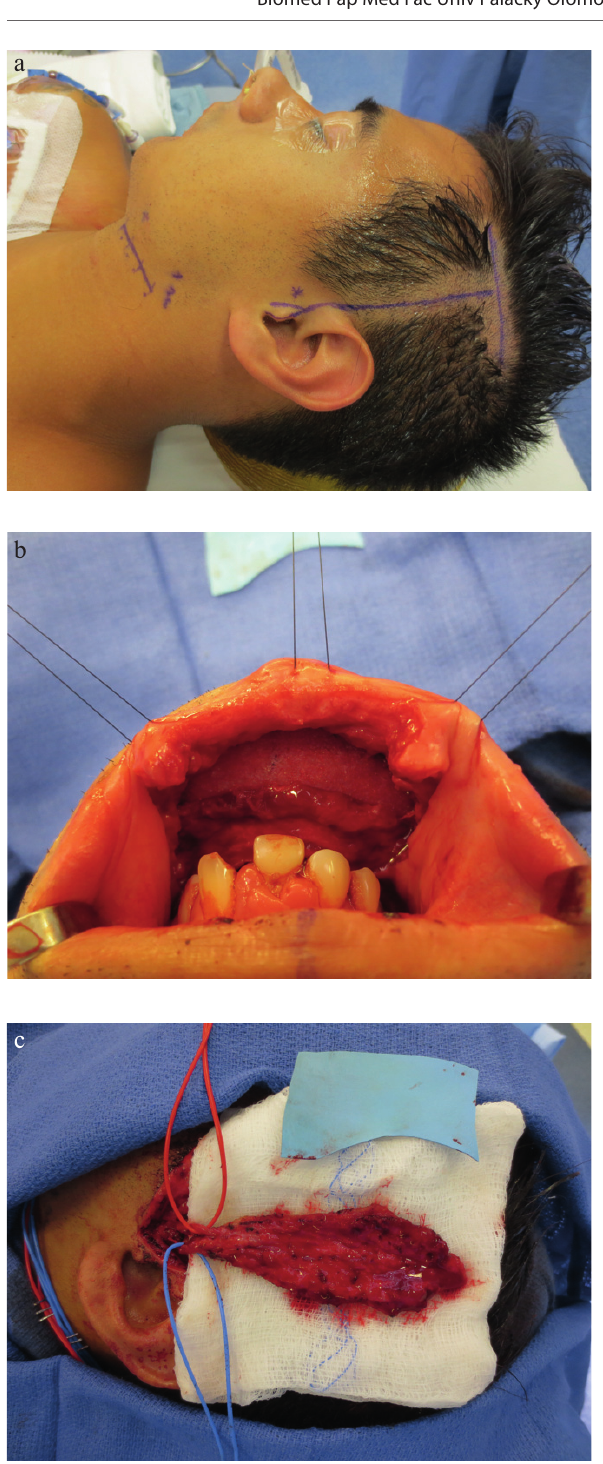
Fig. 3. a (left), b (middle), c (right) : The left picture shows the preoperative incision lines for the temporoparietal free flap and its facial artery anastomosis. The middle picture demonstrates the chin implant before flap insertion (right picture).